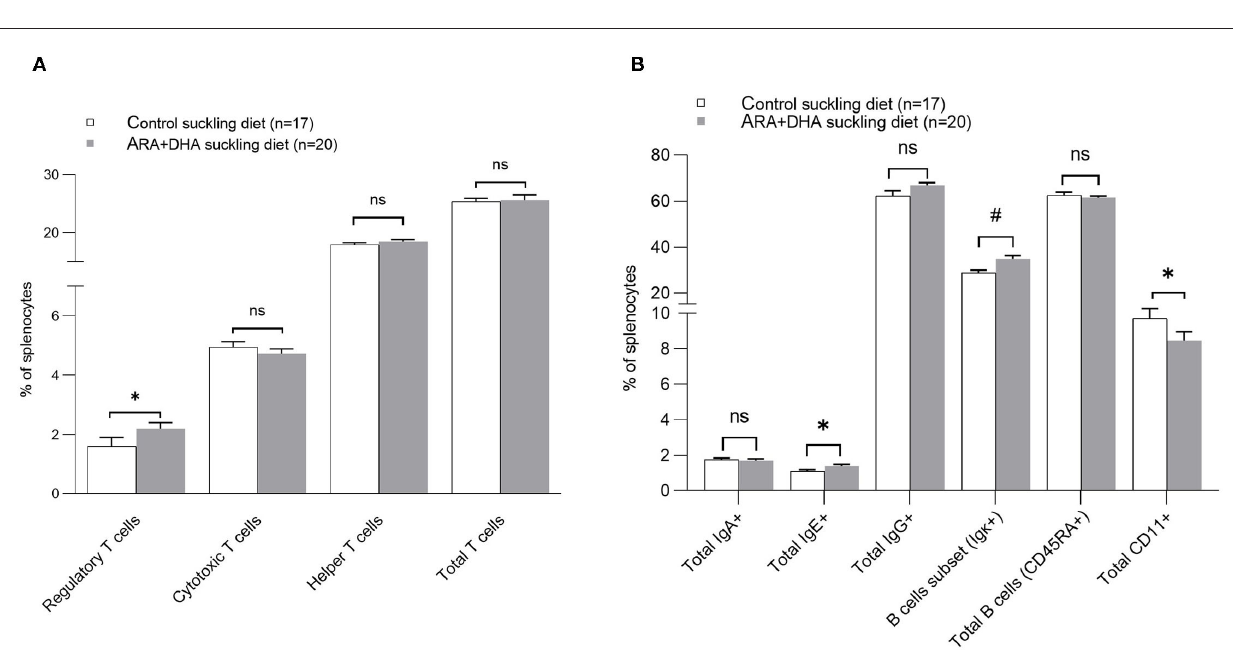
FIGURE 4 | The effect of suckling diet on the immune cell phenotypes of spleen from 8 weeks offspring. The major proportion of T cells are shown (A) and other major immune cell phenotypes (B) . The values are shown in the mean ± SE for each suckling diet group. The P -value for the main effect of suckling diet [Regulatory T cells: P = 0.04, Helper T cell: p = 0.77, Cytotoxic T cells: p = 0.78, Total T cells: p = 0.83, IgA: p = 0.36, IgE: p = 0.02, IgG: p = 0.37, B cell subset: p = 0.001, Total B cells (CD45RA + ): p = 0.35 and monocytes/macrophages (CD11 + ): p = 0.03] are also presented in Table 4 . The significant suckling diet effect is shown by asterisk. The suckling diet and post-weaning diet interaction effect on the B cell subset are shown by the number sign (#), P interaction = 0.02. *, indicates statistical significance was assumed at P < 0.05. was only observed when the offspring were weaned to control of activated B cells (OX12 + , p < 0.001) in splenocytes in the post-weaning diet, as revealed by a significant suckling diet the ARA + DHA suckling diet group compared to the control X post-weaning diet interaction ( Table 4 suckling diet (36.6 ± 1.5 vs. 27 ± 0.9, p < 0.001). However, this